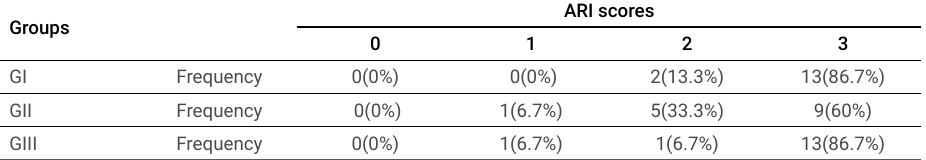
Table 2. Frequency distribution of adhesive remnant index (ARI) of groups studied